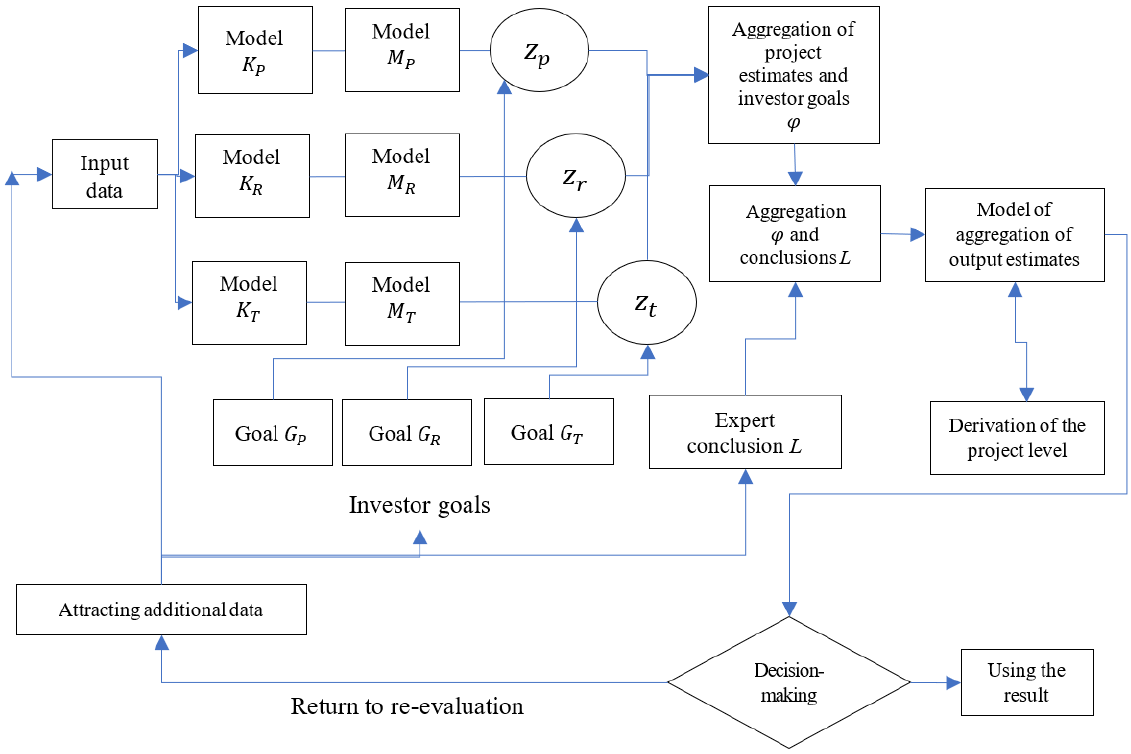
Figure 1. Block diagram of the complex hybrid model.